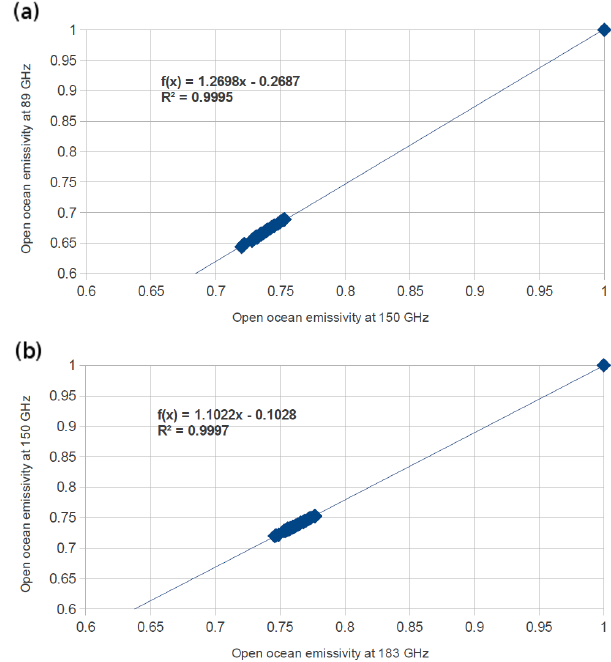
Figure 2. Regression plot for ocean surface emissivity at 89 and 150GHz (a) and at 150 and 183GHz (b)